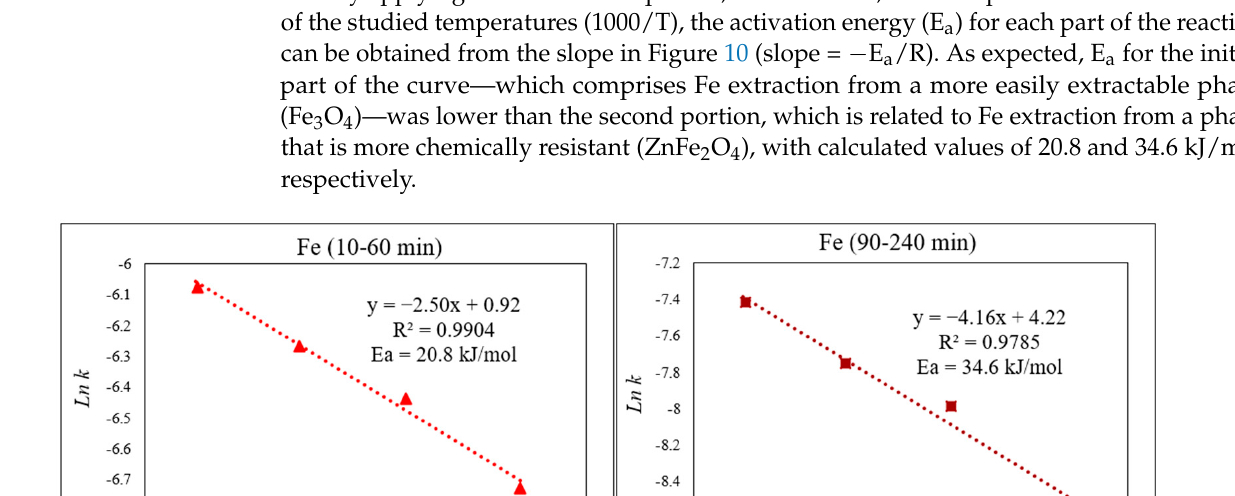
Figure 9. Graph of [1 − 3(1 − X) 2/3 + 2(1 − X) = k.t] over time at different temperatures of 55–85 °C for